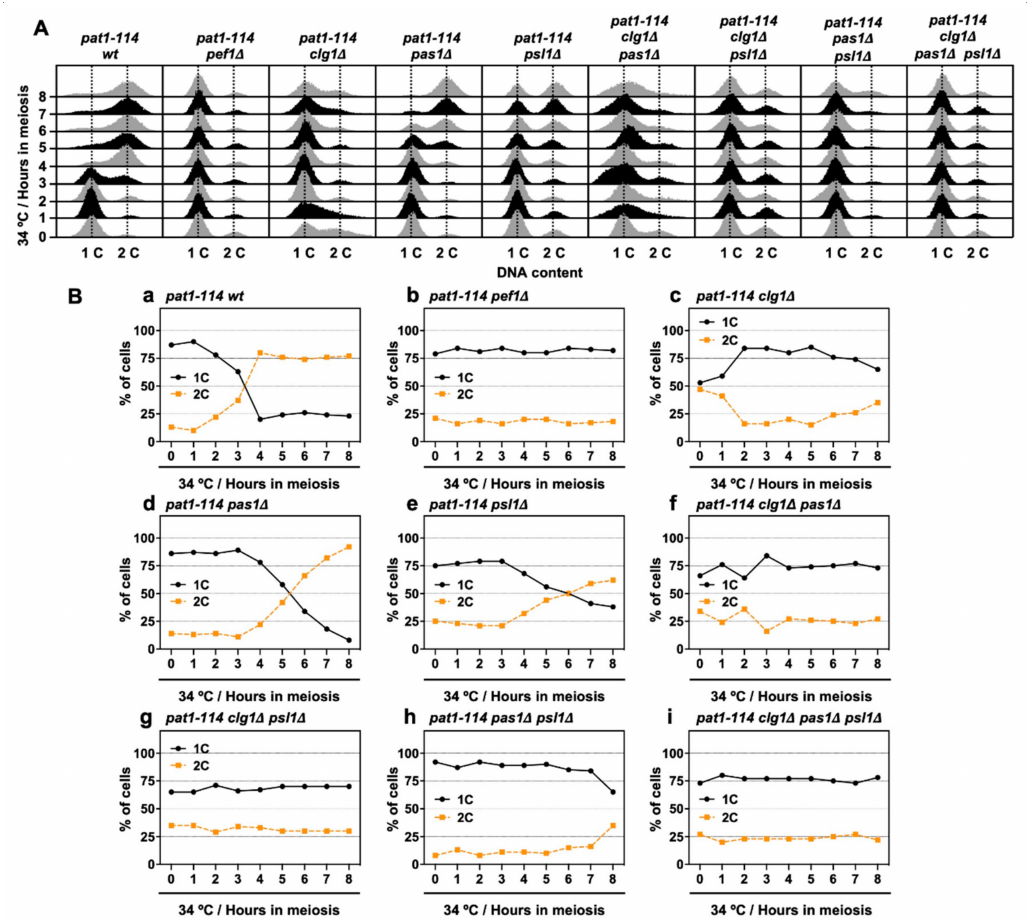
Figure 6. clg1 deletion blocks pre-meiotic DNA replication. ( A , B ) pat1-114 wt (FY7052) (Ba), pat1-114 pef1 ∆ (MS030) (Bb), pat1-114 clg1 ∆ (MS105) (Bc), pat1-114 pas1 ∆ (MS106) (Bd), pat1-114 psl1 ∆ (MS107) (Be), pat1-114 clg1 ∆ pas1 ∆ (MS155) (Bf), pat1-114 clg1 ∆ psl1 ∆ (MS119-1) (Bg), pat1-114 pas1 ∆ psl1 ∆ (MS156) (Bh) and pat1-114 clg1 ∆ pas1 ∆ psl1 ∆ (MS126-2) (Bi) were nitrogen-starved for 14–16 h. Synchronous meiosis was induced by shifting cultures from a permissive temperature (25 ◦ C) to a restrictive temperature (34 ◦ C). The cells were fixed at the indicated times and then stained with PI. DNA contents were measured by flow cytometry analysis ( A ). Graphs indicate the percentages of cells with an unreplicated DNA content (1C, black solid line) and replicated DNA content (2C, orange broken line) after the induction of synchronous meiosis ( B ). Results are expressed as averages from two independent